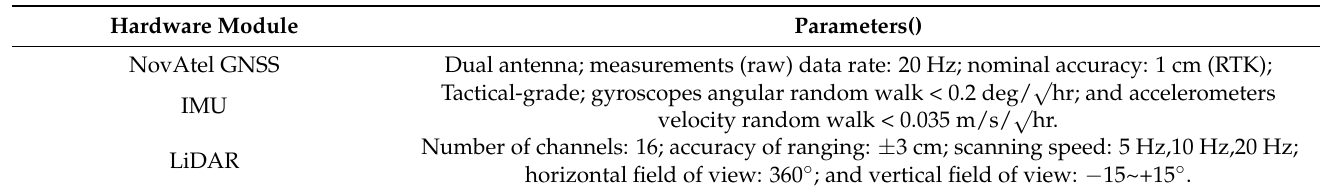
Table 1. Parameters of each hardware module.